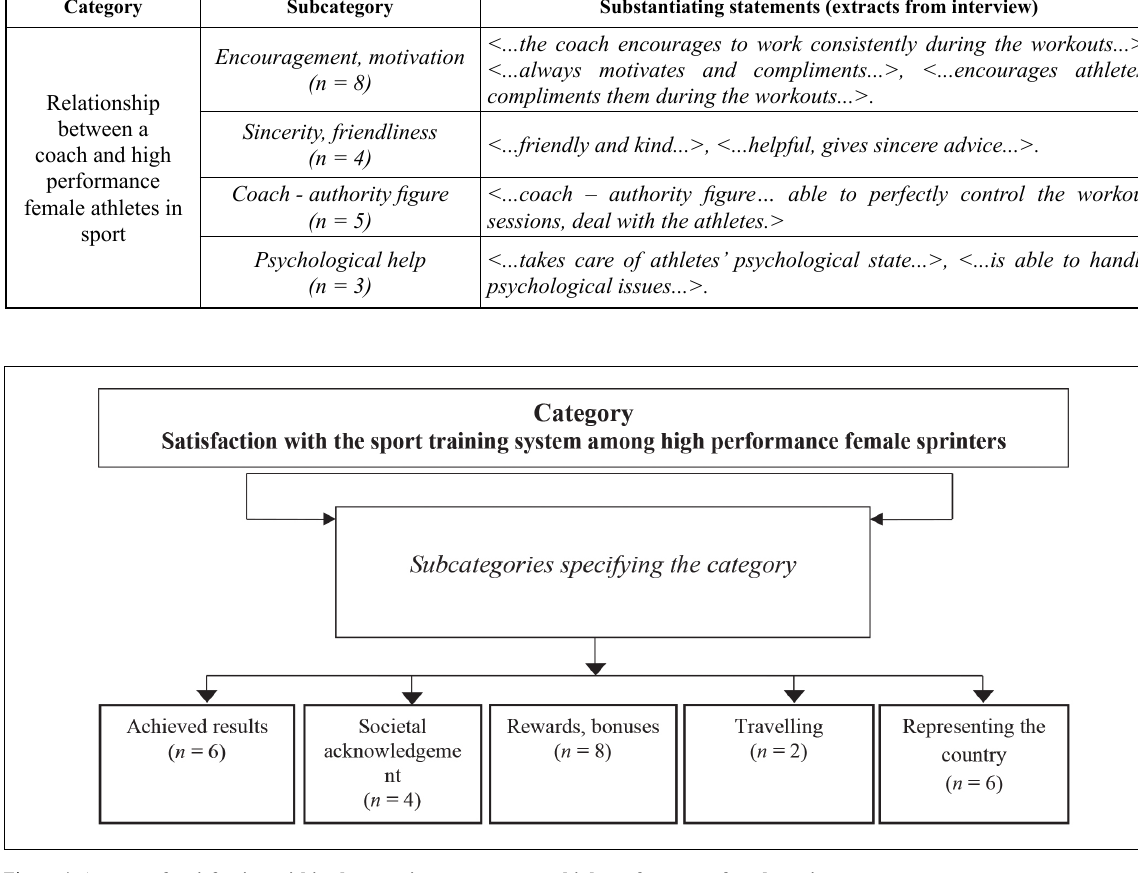
Figure 4. Aspects of satisfaction within the sporting career among high performance female